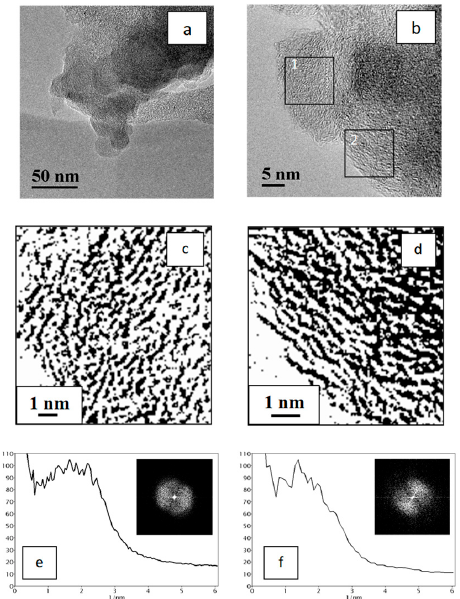
Figure 4. TEM image of PCCNC with the aggregate of NGC globules residing in the carbon matrix ( a ); TEM image with the NGC region (fragment 1) and the carbon matrix region (fragment 2) marked by squares ( b ); fragment 1 ( c ) and fragment 2 ( d ) in the binary form; RCIP obtained by processing the FFT images displayed in the insets: fragment 1 ( e ) and fragment 2 ( f ) (units on the x axis correspond to the inverse distance between graphene layers,